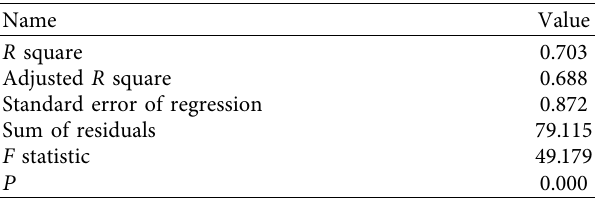
Table 9: Statistics of quadratic models (mean absolute values of the acceleration slopes).